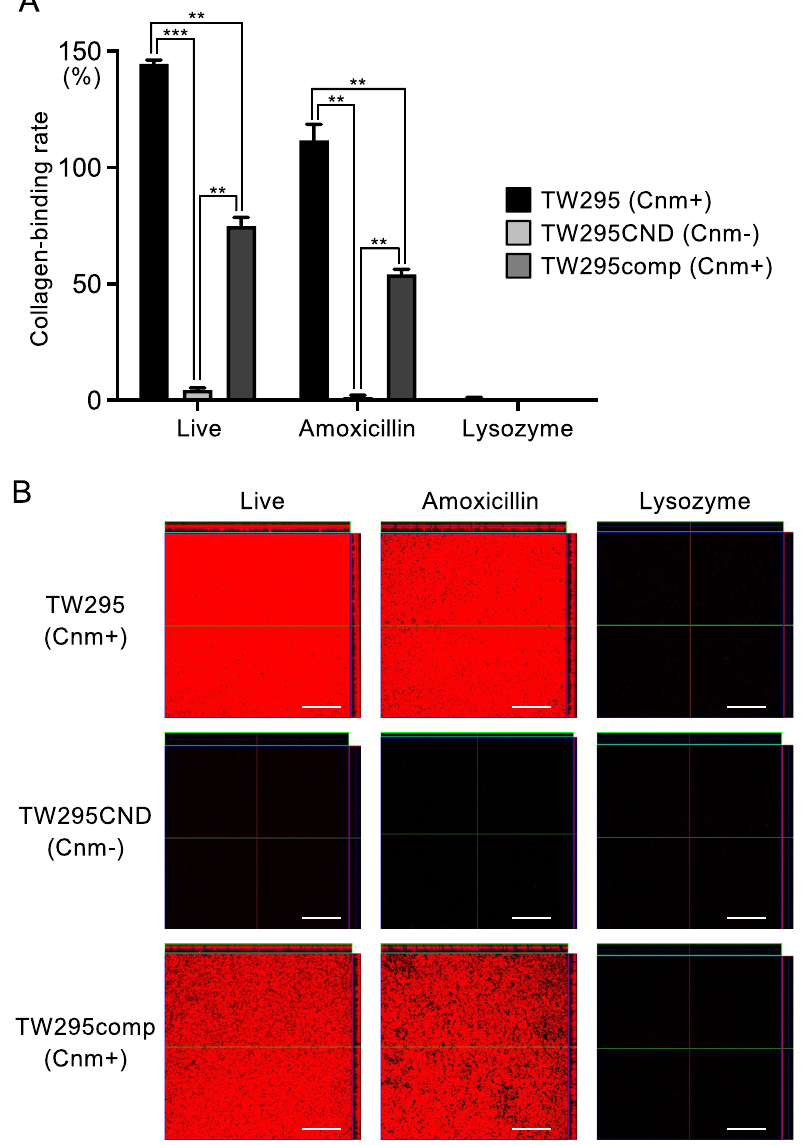
Figure 2. Collagen-binding properties of live S. mutans , amoxicillin-killed S. mutans , and lysozyme-killed S. mutans . ( A ) Collagen-binding rates of S. mutans strains. Significant differences were observed using analysis of variance with Bonferroni correction (** P < 0.01 and *** P < 0.001). ( B ) Representative confocal laser scanning microscopy images of S. mutans binding to collagen. Bacterial cells are stained red. Scale bar, 50